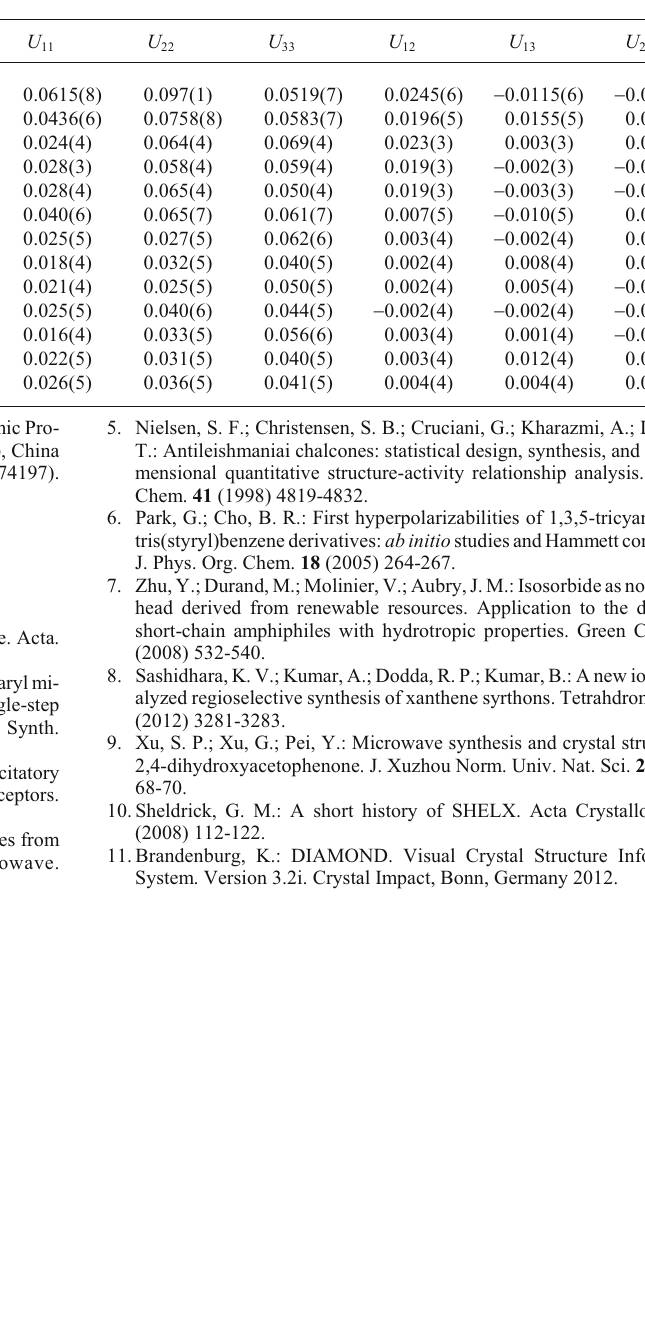
Table 3. Atomic coordinates and displacement parameters (in Å 2 )